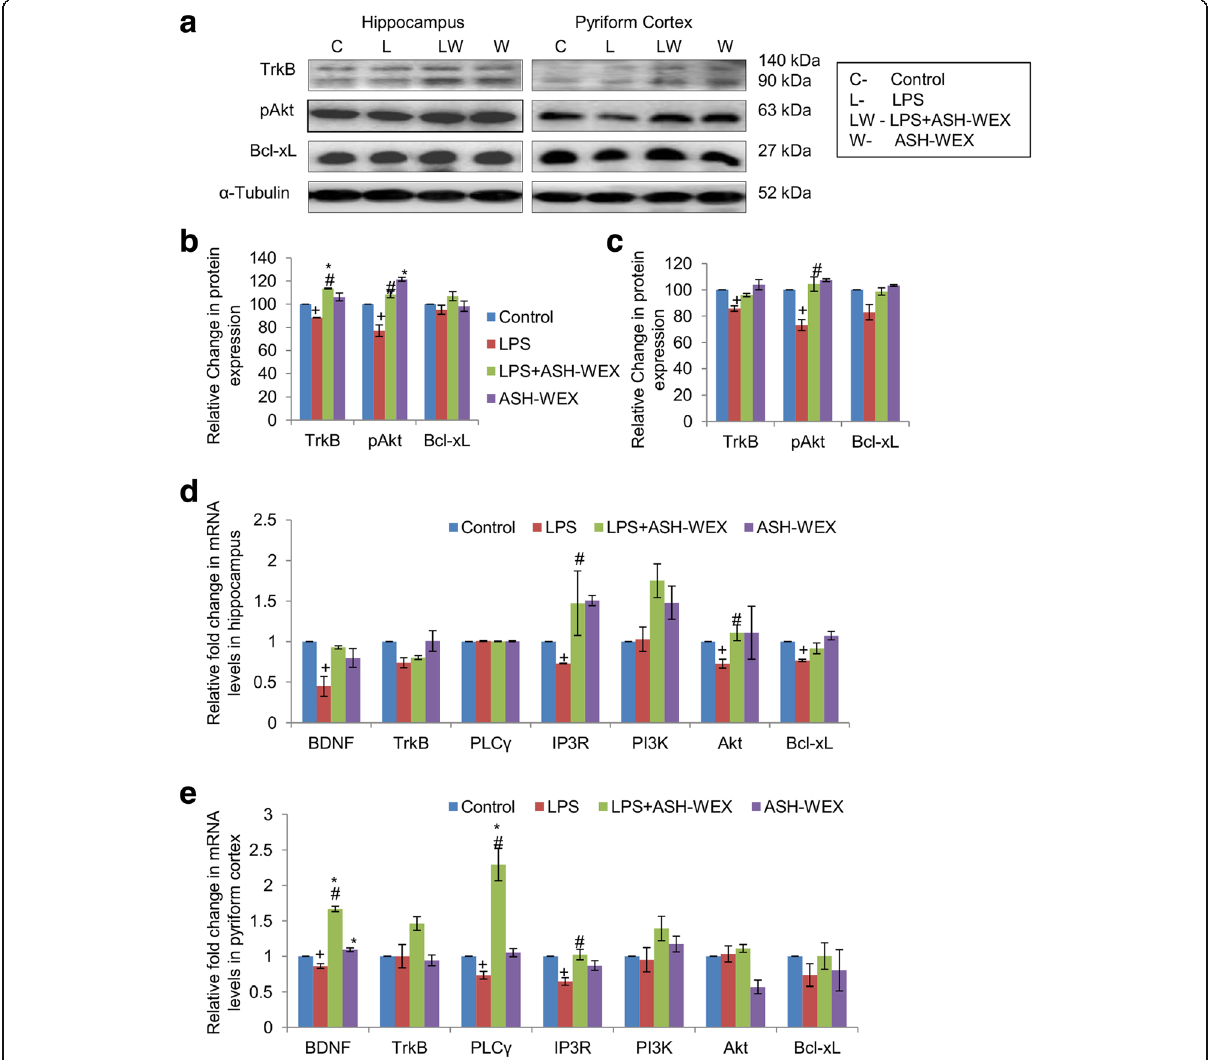
Fig. 4 ASH-WEX restores BDNF – TrkB signaling proteins ( a ) Representative immunoblots of the TrkB, pAkt, Bcl-xL in hippocampus (left panel) and pyriform cortex (right panel) regions of brain amidst the four group of animals (n = 4 – 5/group). ( b , c ) histograms presenting relative densitometric analysis in ( b ) hippocampus and ( c ) pyriform cortex regions amidst the different treatment groups plotted as Mean ± SEM (taking control group as 100%). α -Tubulin was used for the normalization of protein expression. ( d , e ) Histograms depicting relative mRNA levels of BDNF, TrkB, PLC γ , IP3R, PI3K, Akt, and Bcl-xL in ( d ) hippocampus and ( e ) pyriform cortex regions amidst the four groups (n = 4 – 5/group) plotted as Mean ± SEM from three independent experiments. * p ≤ 0.05 control versus ASH-WEX alone and LPS + ASH-WEX groups. + p ≤ 0.05 control versus LPS alone group. # p ≤ 0.05 LPS alone versus LPS + ASH-WEX group (one-way ANOVA with Holm-Sidak post hoc